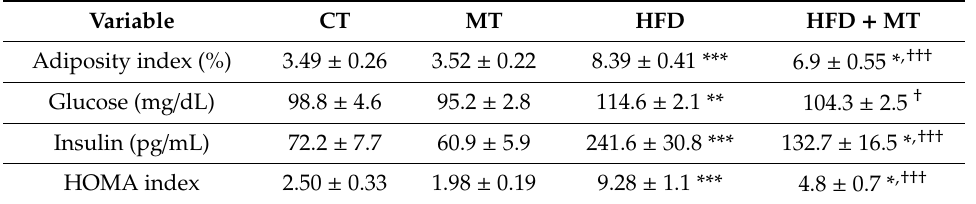
Table 1. E ff ect of the mitochondrial antioxidant MitoTempo (MT; 0.7 mg / Kg / day i.p) on metabolic parameters in rats fed a normal chow (CT) and high fat diet (HFD) fed rats.